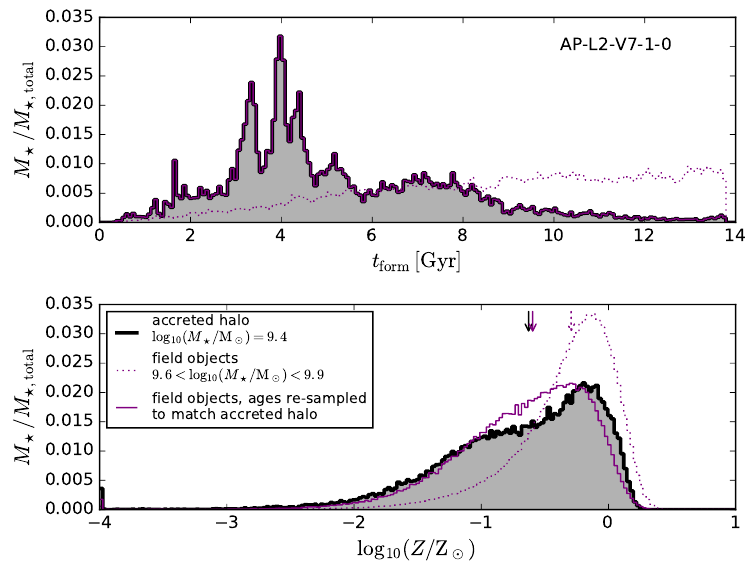
Figure 2. The upper panel shows the formation time distribution for stars in the accreted halo of AP-L2-V7-1-0, one MW or M 31-like galaxy from the APOSTLE suite (filled histogram); the lower panel is similar but for the metallicity distribution. The dotted purple histogram shows the same distributions for field (central) objects which have stellar masses in the range 10 9.6 –10 9.9 M (cid:12) , i.e., 0.2–0.5 dex more massive than the accreted halo of AP-L2-V7-1-0. The result of re-weighting the stellar populations of the field objects, weighted by the formation time distribution of the accreted halo, is shown with the solid purple histogram (by construction, the formation time distribution is then a perfect match). This enforced bias toward older stars in the field objects results in a re-sampled metallicity distribution which resembles much more closely that of the accreted halo. Arrows mark the median of the distribution with corresponding line